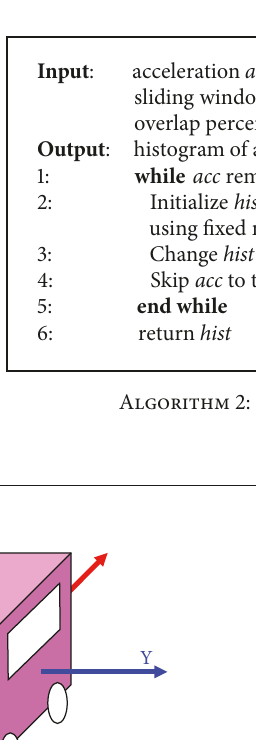
Algorithm 1: Inactive-period filtering algorithm.